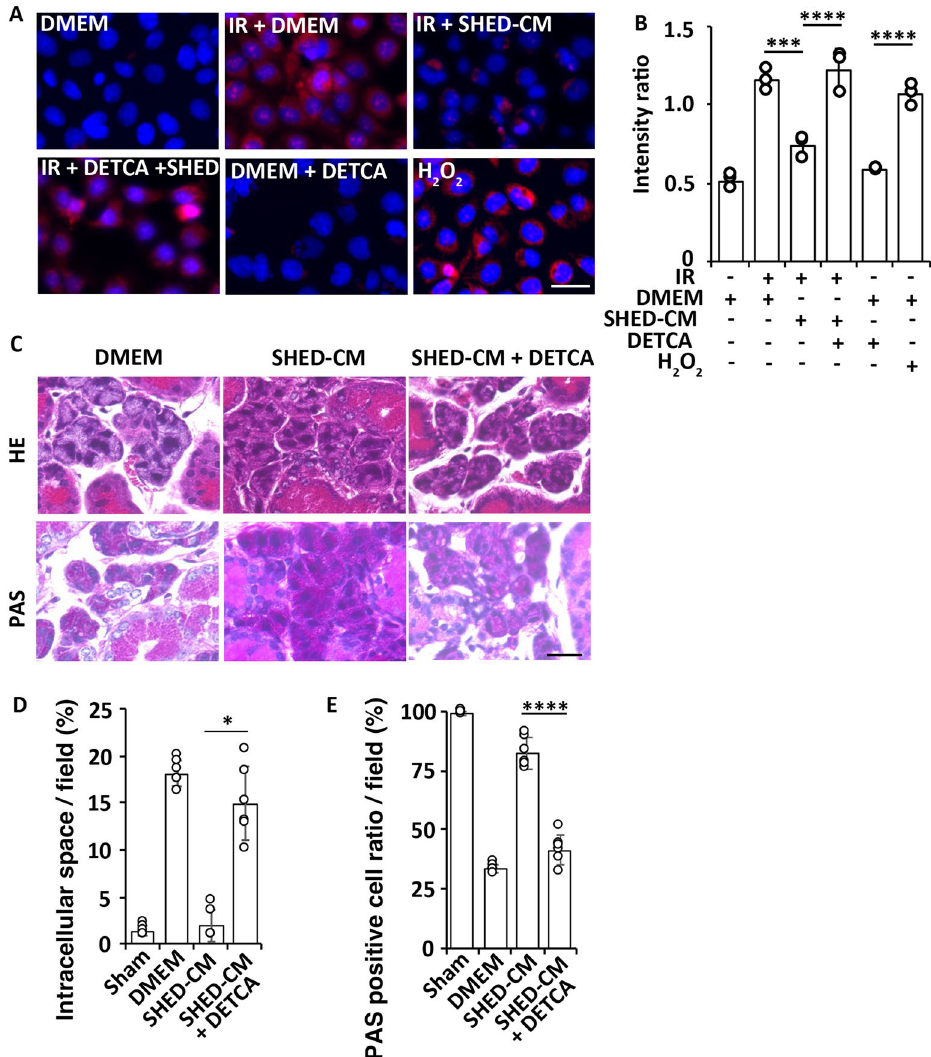
Figure 7. Effects of DETCA on the antioxidative and tissue preservation effects of SHED-CM after irradiation. ( A ) Representative immunofluorescence images of MitoSOX and nuclear DAPI of NS-SV-AC 48 h after irradiation. H 2 O 2 was used as the positive control. Scale bar: 100 μm. ( B ) Quantitative analysis of the fluorescence intensities of MitoSOX analysis. The average fluorescence intensities are significantly lower in the irradiated NS-SV-AC-treated with SHED-CM than DMEM. The antioxidant effect of SHED-CM is abolished after treatment with the SOD inhibitor DETCA (n = 3). ( C ) Representative images of the H&E or PAS staining of the mouse SG at 24 h after the last CM treatment (n = 6). Scale bar: 100 μm. ( D ) Quantification of the intercellular space in the H&E staining (data presented by percent area per 250-μm 2 field). ( E ) PAS positive cell ratio in total acinar cell number. Data are represented as means ± SDs. Comparisons between groups were analyzed using an ANOVA with Tukey’s multiple comparison test [( B ), ( E )] or a Kruskal–Wallis test/Dunn’s multiple comparison test ( D ) (* p < 0.05, ** p < 0.01, *** p < 0.001, **** p < 0.0001). CM, conditioned medium; DETCA, diethyldithiocarbamate; Fibro, fibroblast; SG, salivary gland; SHED, stem cells from human exfoliated deciduous teeth; SOD, superoxide